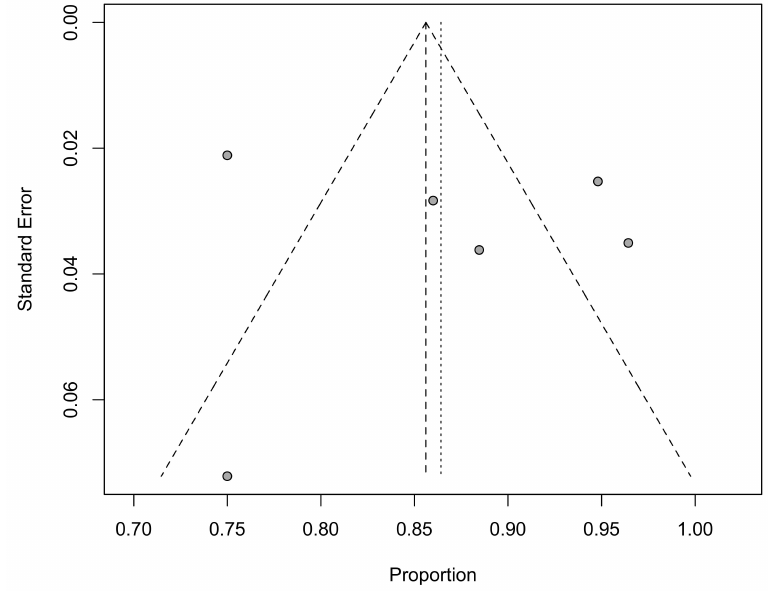
Figure 10. Funnel plot showing studies evaluating RTS after